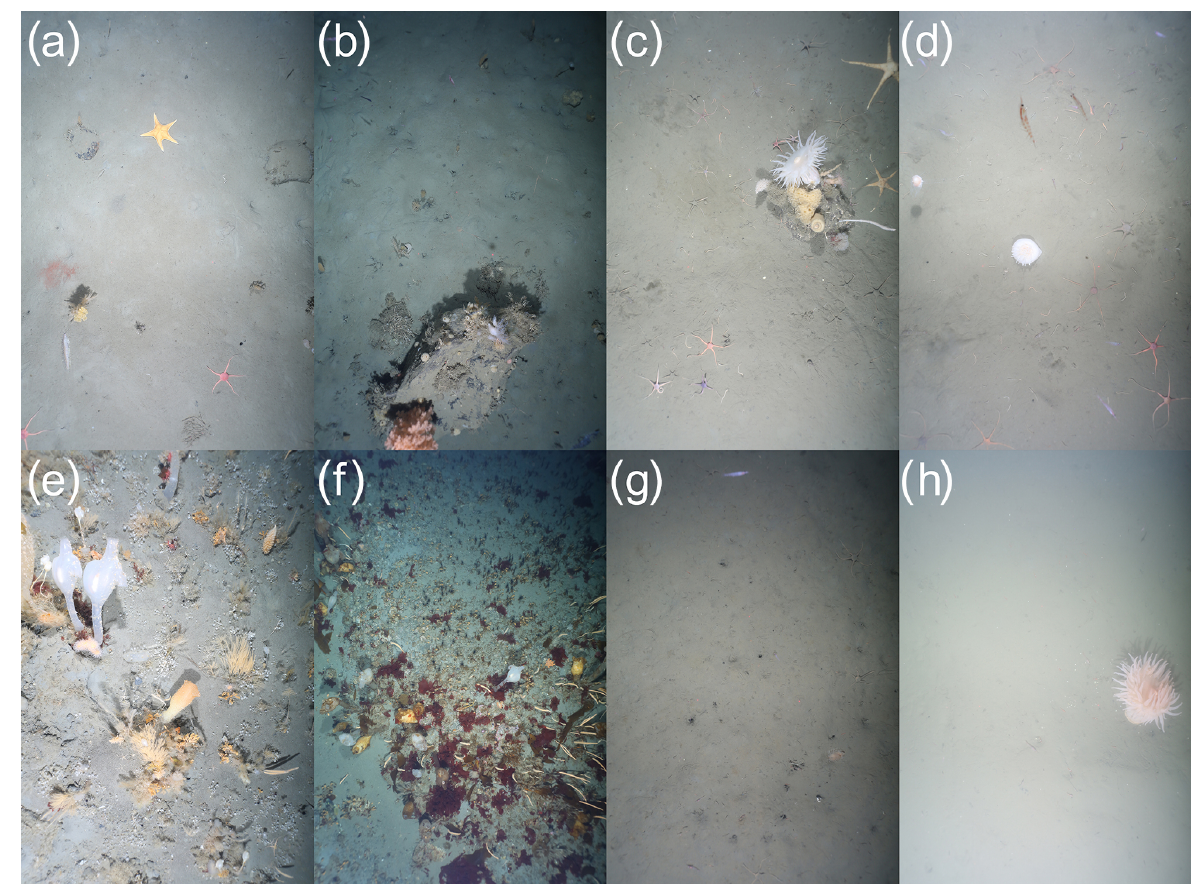
Figure 3. Typical seafloor images collected from each of the OFOBS surveys made of the Weddell Sea seafloor during RV